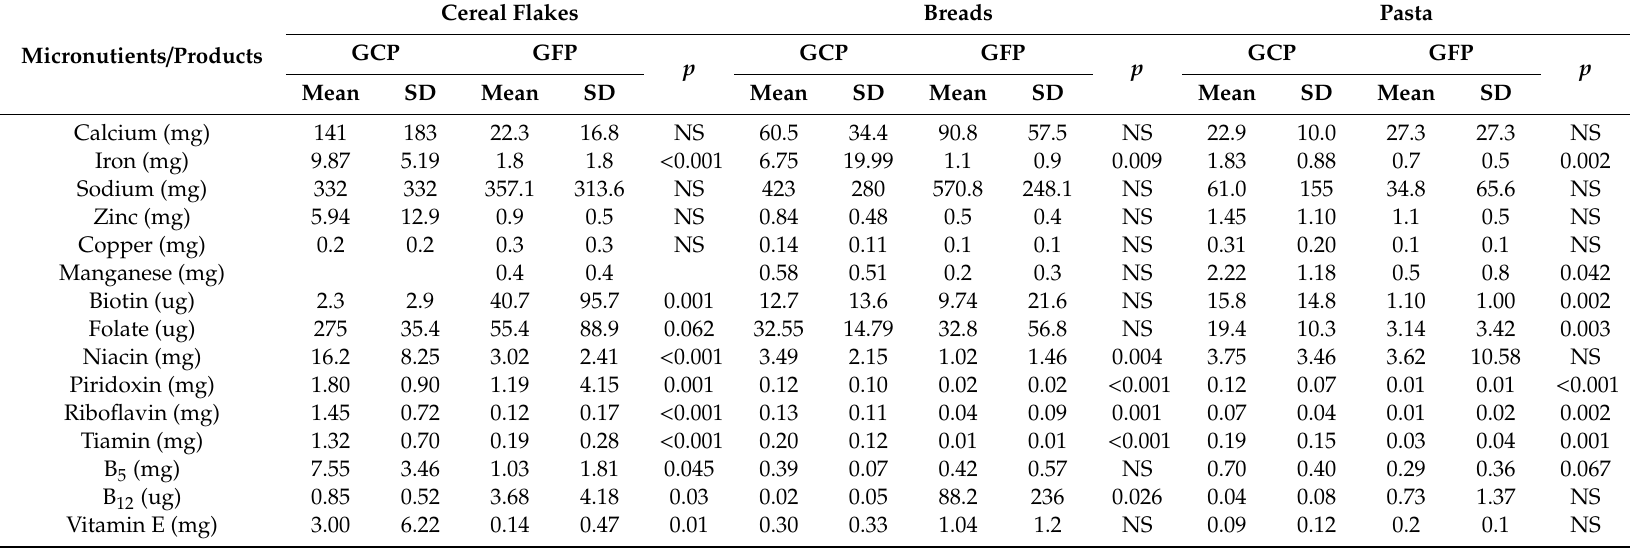
Table 2. Analytical [4] micronutrient content in gluten-free rendered foodstu ff s divided by food groups, compared to gluten-containing products, expressed by 100 g of foodstu ff